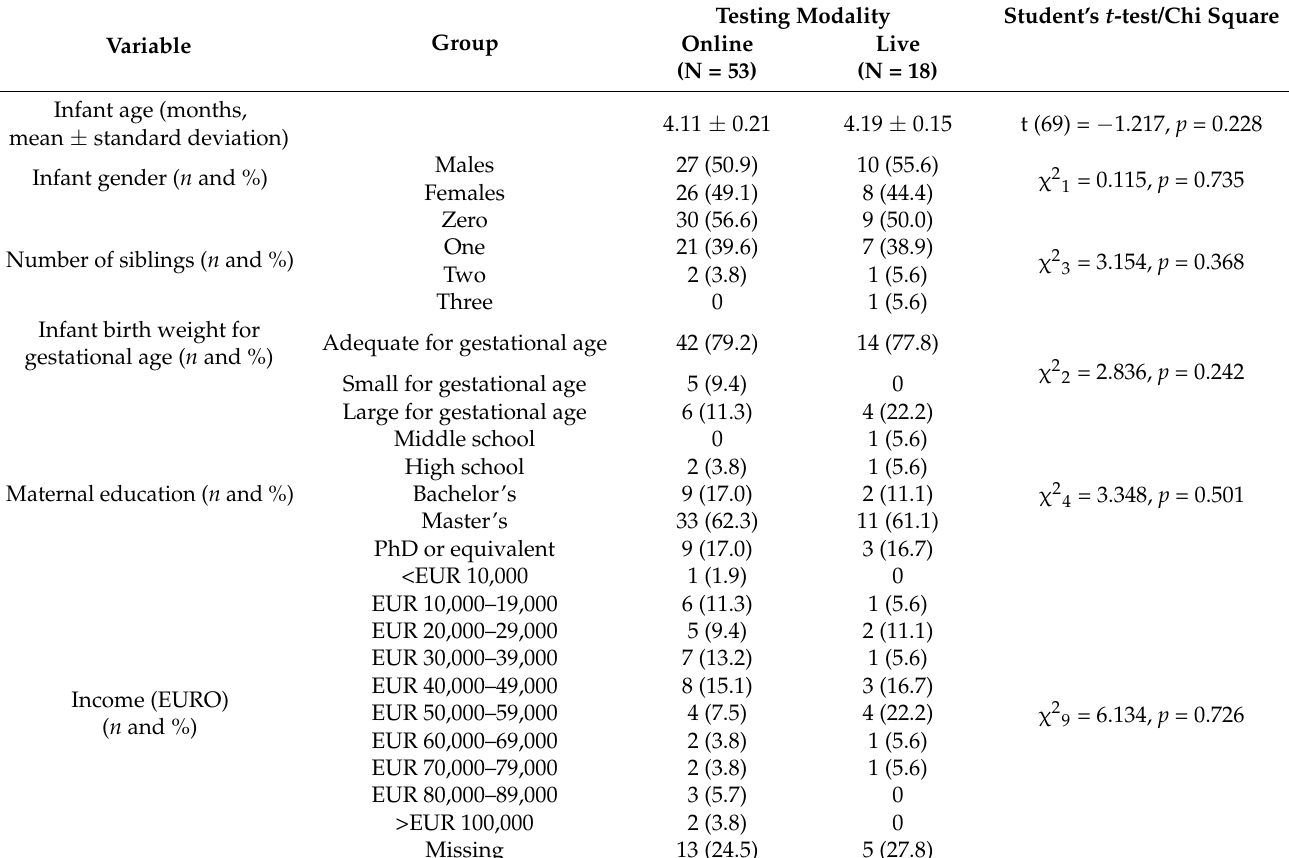
participants (tested “online” or “live”), and the statistical values (Student’s t -test or Chi square) for the comparisons between the two